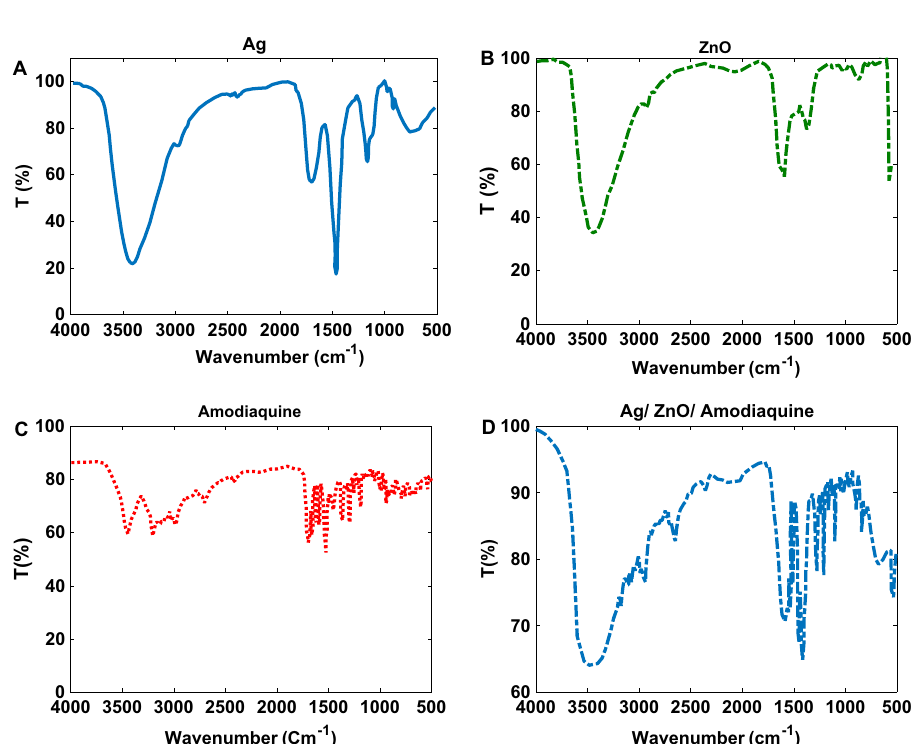
Figure 5. FT-IR spectra of the ( A ) Ag NPs ( B ) ZnO NPs, ( C ) Amodiaquine, ( D ) synthesized Ag/ZnO/ Amodiaquine